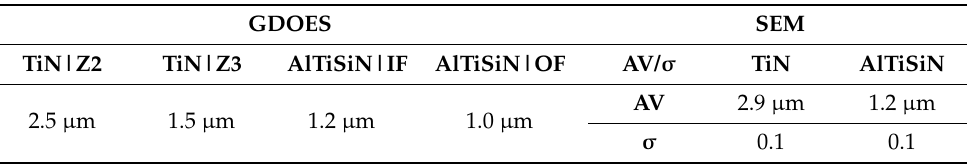
Table 5. Values of thickness for both